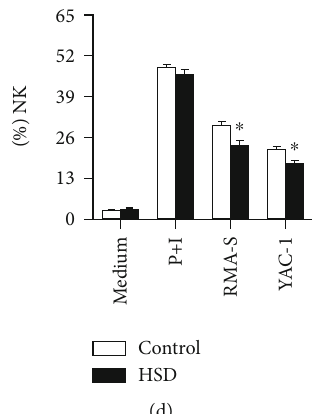
Figure 4: Secretion of CD107a and IFN- γ is de fi cient in NK cells from HSD-fed mice following stimulation with tumor cells. Representative fl ow cytometry pro fi les and percentage of CD107a (a, b) and IFN- γ (c, d) expression in poly (I:C)-activated splenic NK cells stimulated with YAC-1 or RMA-S tumor cells. All the data represent at least three independent experiments. Data are shown as the means ± SEM . Unpaired Student ’ s t -tests (two-tailed) were performed using the Prism software. A P value of < 0.05 was considered signi fi cant. ∗ P < 0 : 05 , ∗∗ P < 0 : 01 , and ∗∗∗ P < 0 : 001